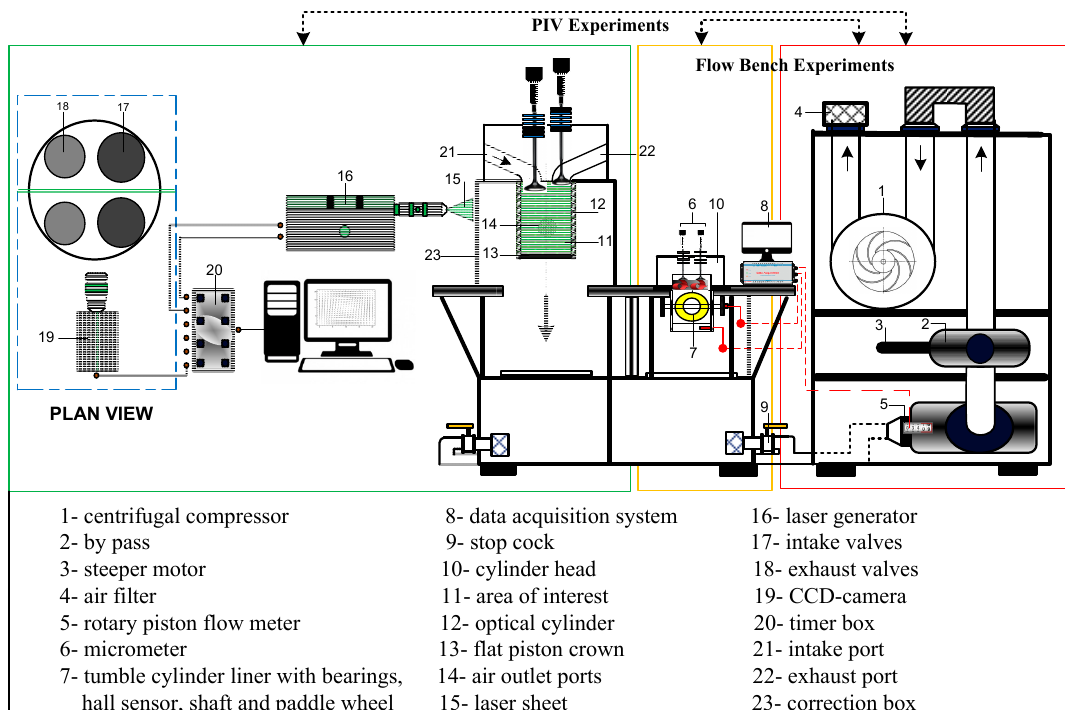
Figure 1. Schematic diagram for both flow bench and Particle Image Velocimetry (PIV) experiments.